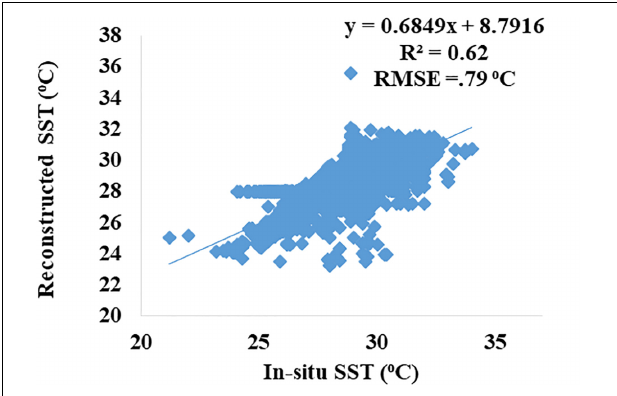
FIGURE 14 | The scatter plot between in situ data and reconstructed SST using DINEOF and in situ validation data for user case study 3 during the period